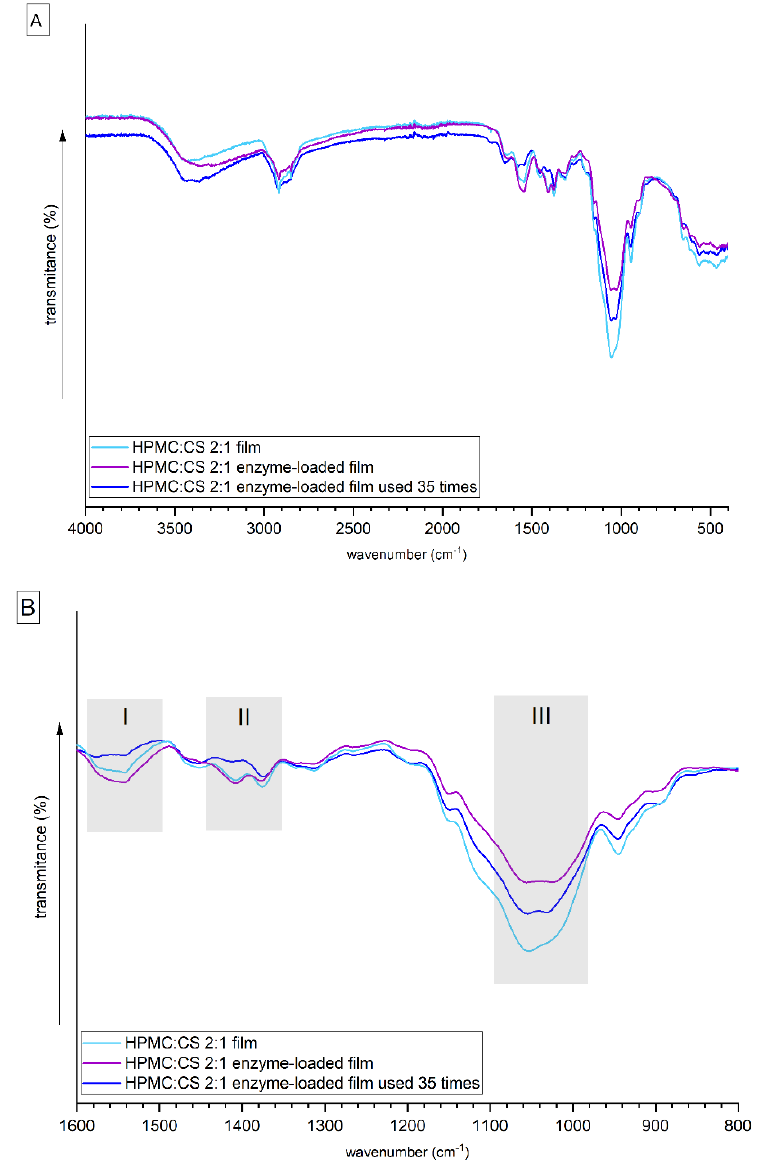
Figure 3. ( A ) Full FTIR spectra for HPMC–CS film. Light blue curve: unloaded film; purple curve: enzyme–loaded film; blue curve: enzyme–loaded film after 35–times usage cycles. ( B ) Focused FTIR spectra from 800 to 1600 cm – 1 . HPMC:CS = 2:1.